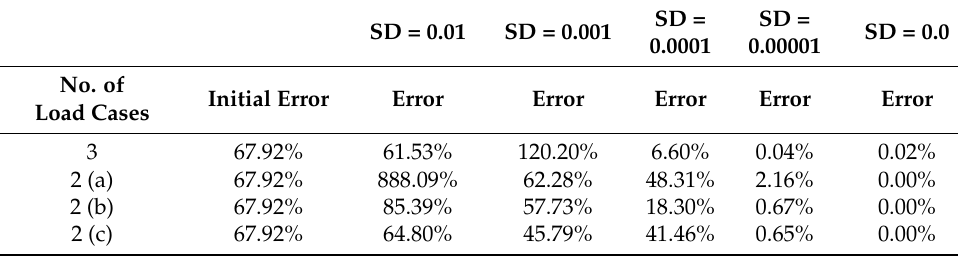
Table 1. Errors obtained for the TMM thermal parameters. Steady state 4 nodes model.